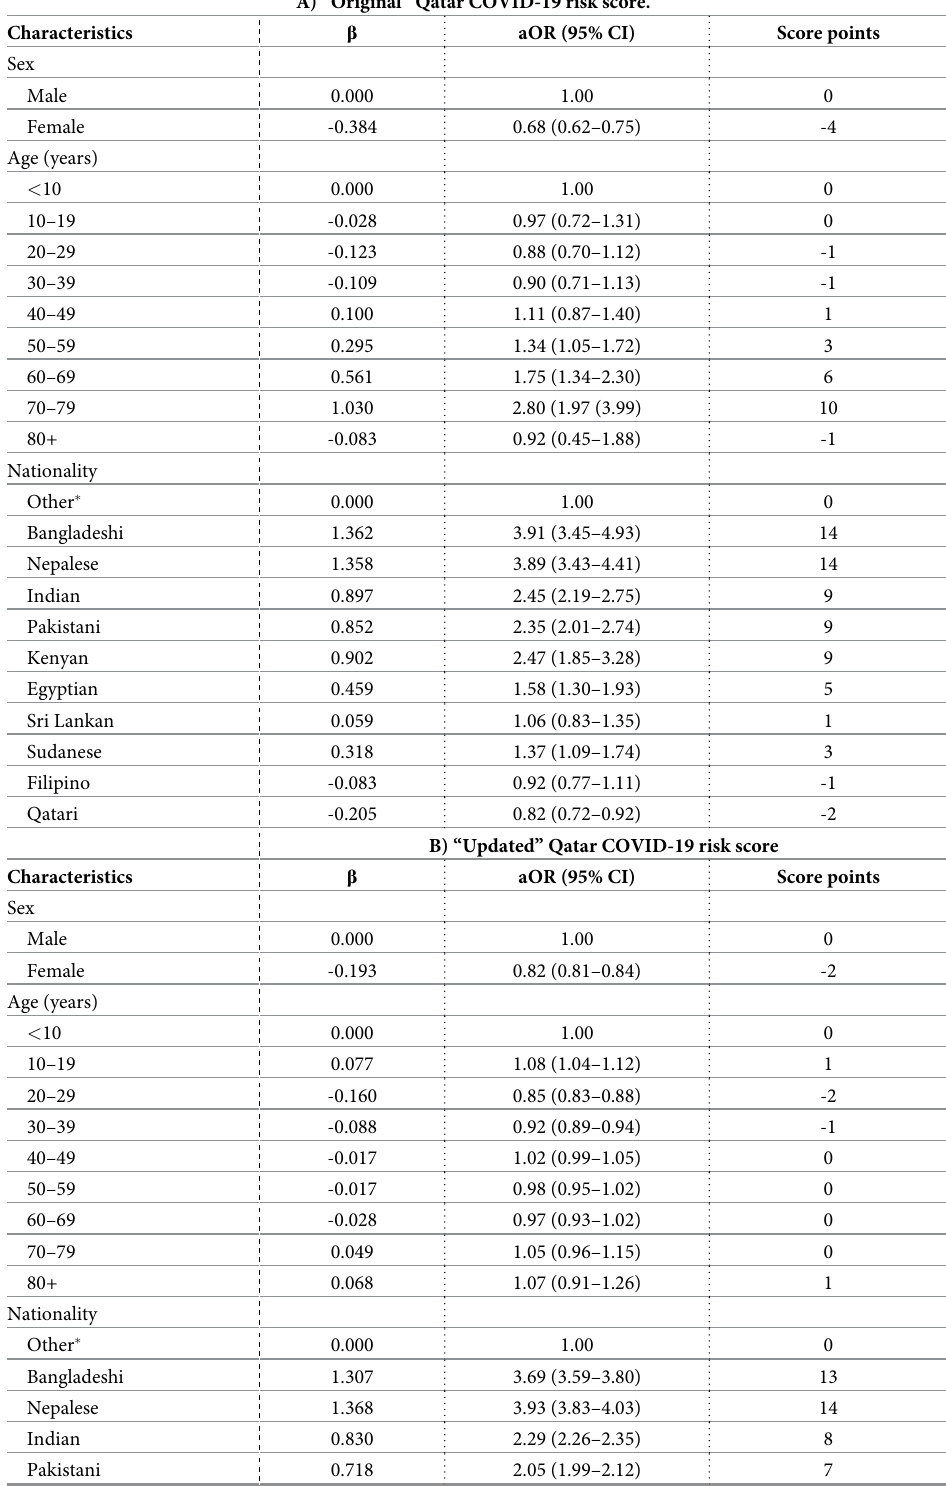
Table 2. Results of regression analyses used to derive a) the original and b) updated Qatar COVID-19 risk scores. A) “Original” Qatar COVID-19 risk score.